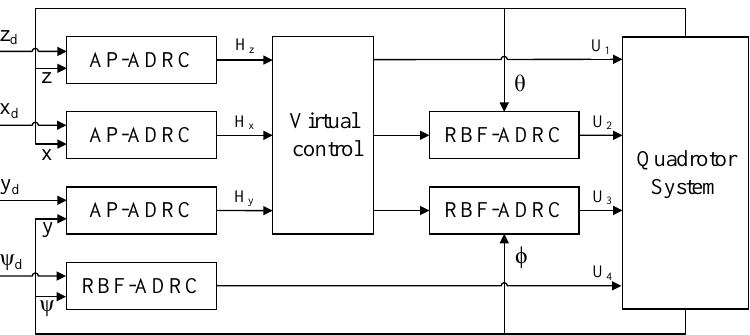
Figure 2. Block diagram of quadrotor control scheme.